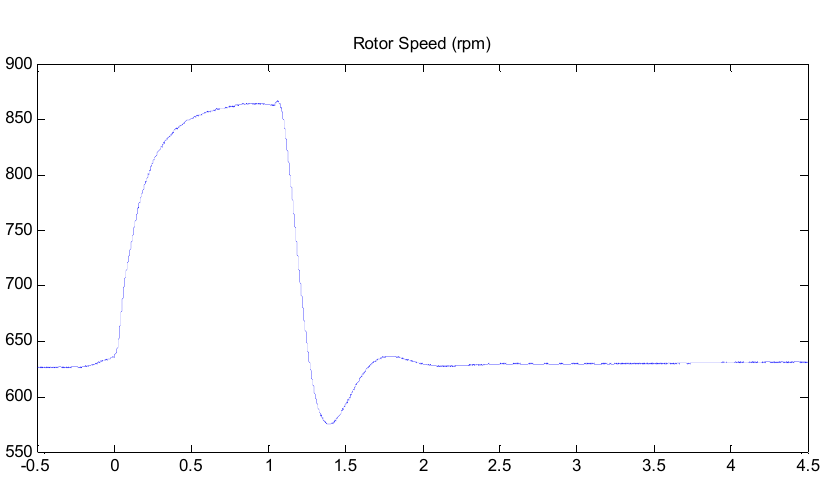
Figure 16. Generator speed, (rpm) vs. time, (s) during